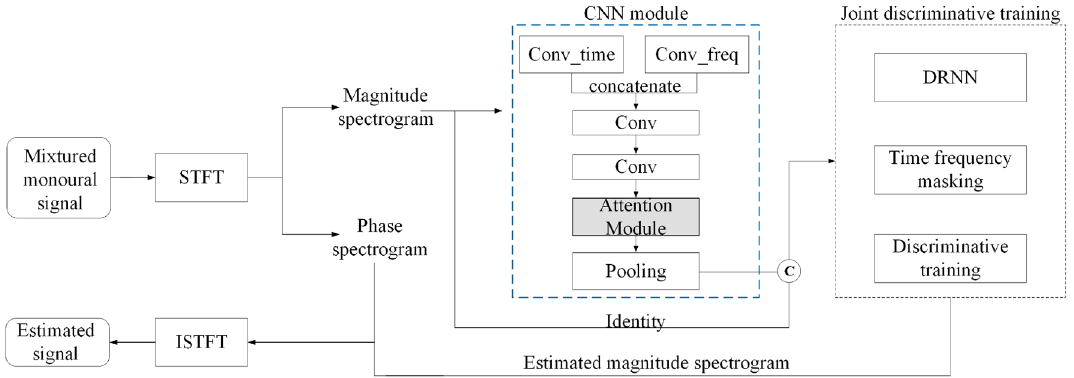
Figure 1. Overview of the proposed CRNN-A framework for speech